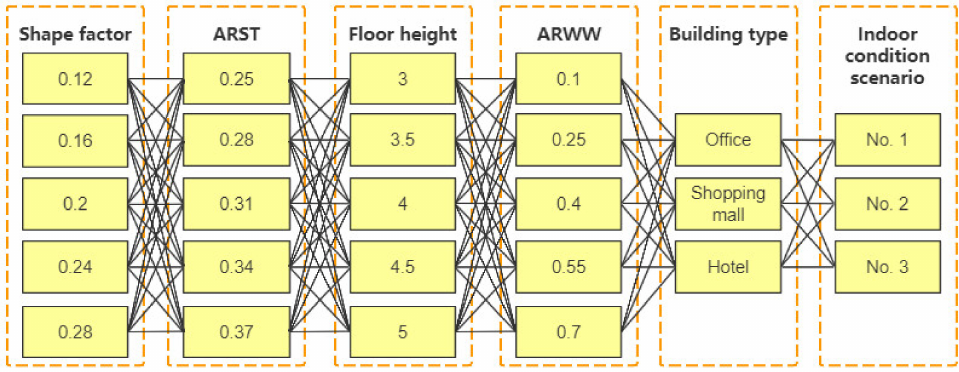
Figure 8. All arrangements of variable model parameters.